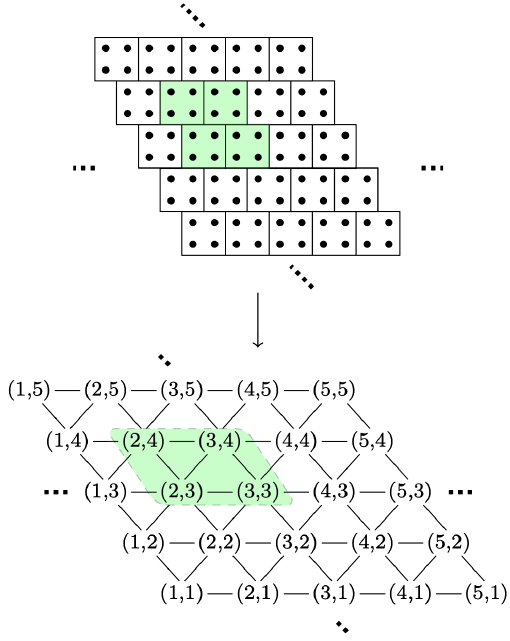
FIG. 4. Upon coarse-graining the elementary degrees of free- dom (dots on the top figure), we obtain a quantum spin system with larger local Hilbert space dimension, on a triangular lattice. Each of the coarse-grained degrees of freedom is referred to as a clusters. After coarse-graining enough times, the local terms of the Hamiltonian can be localized to a 2 × 2 cluster (green). The pair of integers represent the x and y coordinates of each lattice site on the coarse-grained